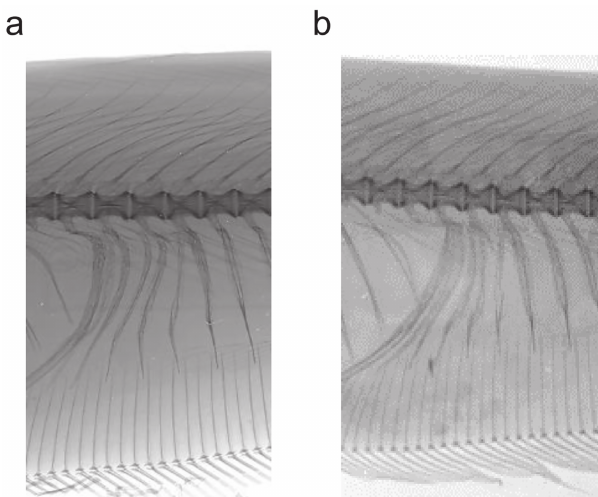
Fig. 4. Radiographs of holotypes of two Sternarchella species showing condition of displaced hemal spines at posterior margin of body cavity. a. Sternarchella terminalis holotype (CAS 54912). b. Sternarchus schotti holotype (NMW 65335)